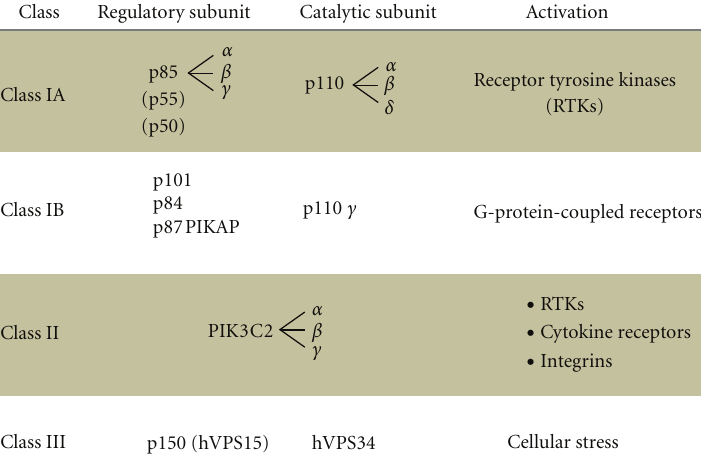
Figure 2: Representation of subclass molecules of PI3K. PI3K is composed of three subclasses based on the substrate, structure, distribution, and mechanism of activation.